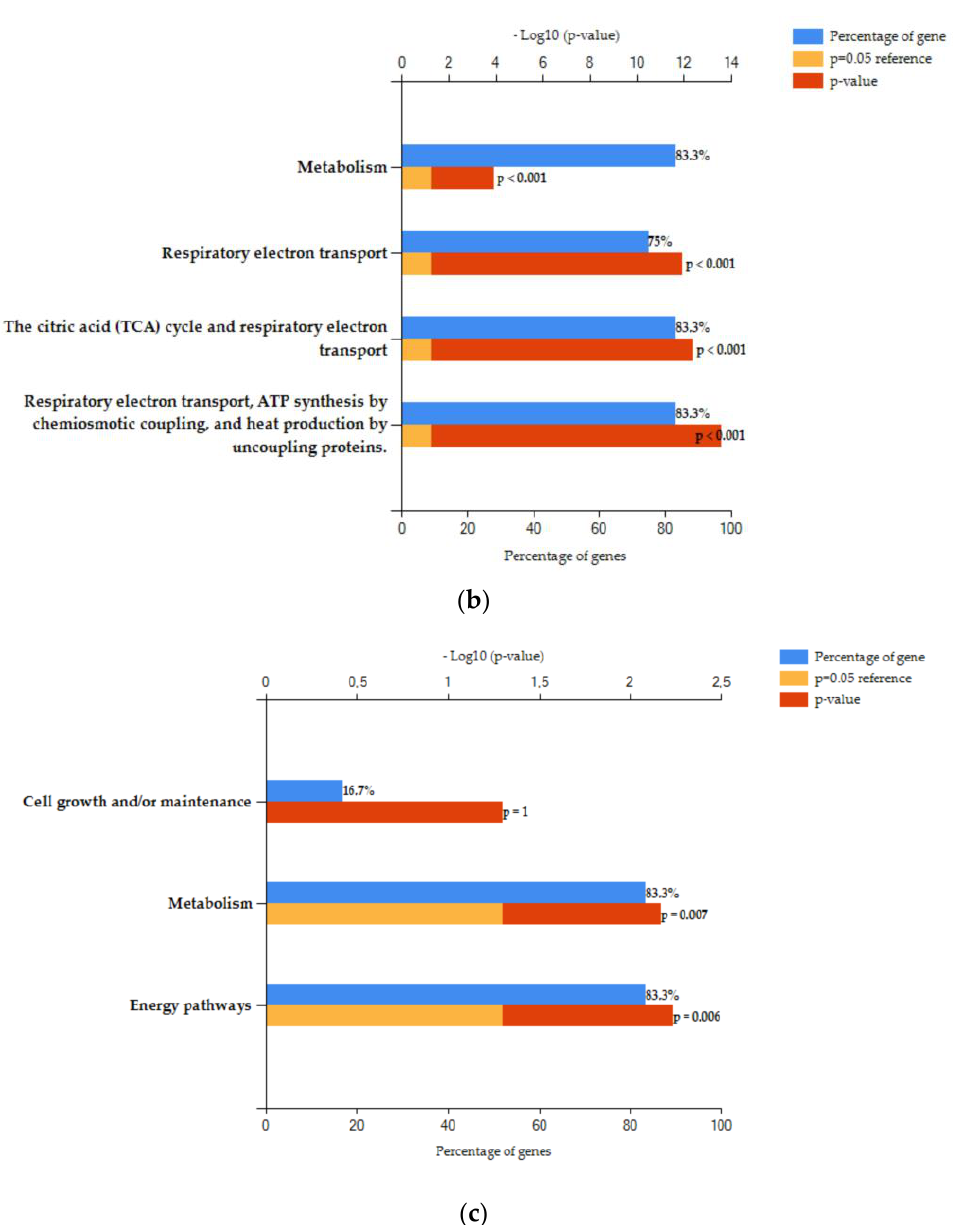
Figure 3. Functional enrichment analysis with FunRich software version 3. ( a ) Pie chart of cellular component enrichment. ( b ) Biological pathway enrichment. ( c ) Biological process enrichment. Percentage of genes involved in each function (blue bar), p -value (red bar), and reference (orange bar).